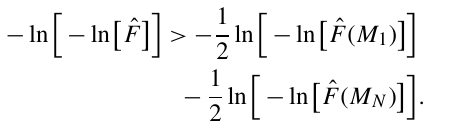
78 . 2MN × m; σ = 2 . 05MN × m; ξ = 0 . 026).